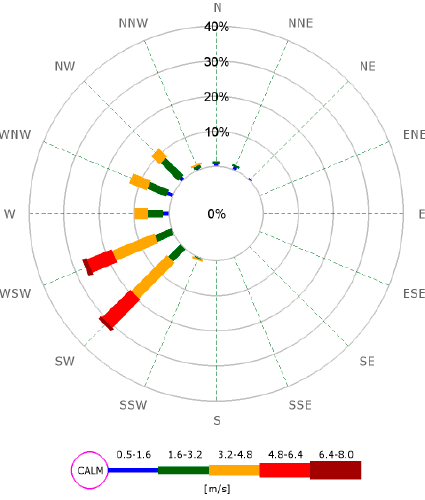
Figure 2. A wind rose created from data taken from the Penrose air quality and meteorological monitoring station run by Auckland Council covering the period 12–24 October 2015.